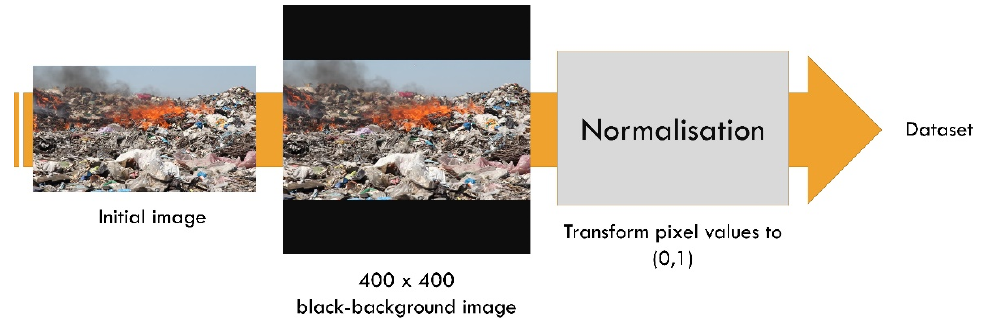
Figure 1. Dataset creation pipeline.